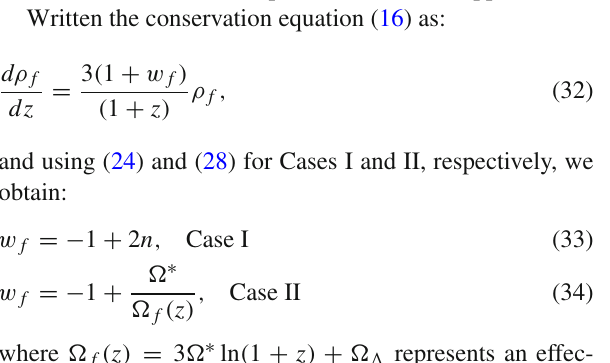
Table 2 Case II: Mean value of the parameters H 0 ( kms − 1 Mpc − 1 ) , (cid:7) (cid:7) (cid:7) ∗ from Fig. 4 and 68%, 95% and 99% c.l. m , b and